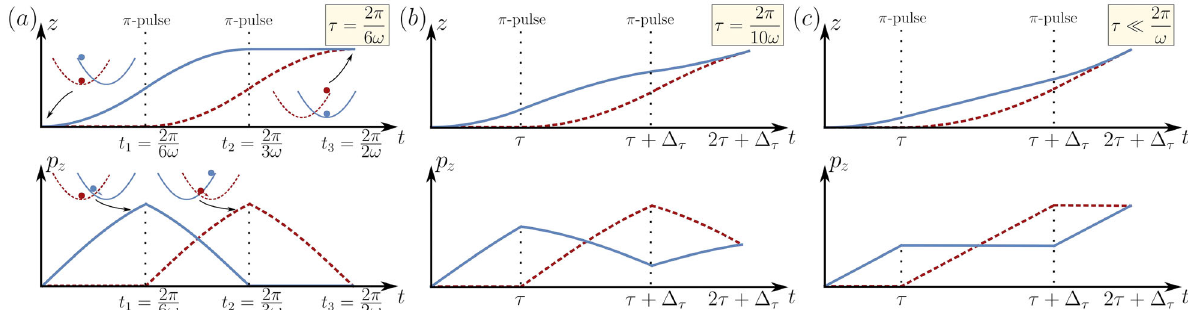
Fig. 2 Interference protocol. An initial π /2-pulse on the Cooper-pair box generates a charge superposition in the endcap electrodes, so that the charged nanoparticle feels a superposition of a spatially shifted and an unshifted harmonic potential. The time evolution (4) gives rise to two wave packets traveling on separate position and momentum trajectories. The corresponding classical trajectories are shown here. To verify this motional superposition state, the wave packets must be reunited. This can be achieved by applying two π -pulses, each interchanging the potentials felt by the two branches, in such a way that the trajectories fi nally coincide in position and momentum. ( a ) In the simplest case all pulses are separated by one sixth of the harmonic oscillation period and the particle is initially at rest. The π /2-pulse then leaves one branch unaffected (red dashed line), while the other one is accelerated (blue line). The fi rst π -pulse accelerates the resting branch and decelerates the moving one to a standstill at the time of the second π -pulse. After that, the blue trajectory remains at rest while the red one is decelerated until it reaches the blue one with zero velocity. ( b ) Even for arbitrary pulse times τ the separation Δ τ between the π -pulses can be chosen such that the corresponding paths in phase space coalesce for all initial states at 2 τ + Δ τ . ( c ) The scheme works for time durations much shorter than the oscillation period, which makes it particularly suitable for limited coherence times. In this short time limit the accelerations are essentially constant and Δ τ = 2 τ ffiffiffiffiffiffiffiffiffiffiffiffiffiffiffiffiffiffiffiffiffi p 2 k B T = M ω 2 is much smaller than z s .